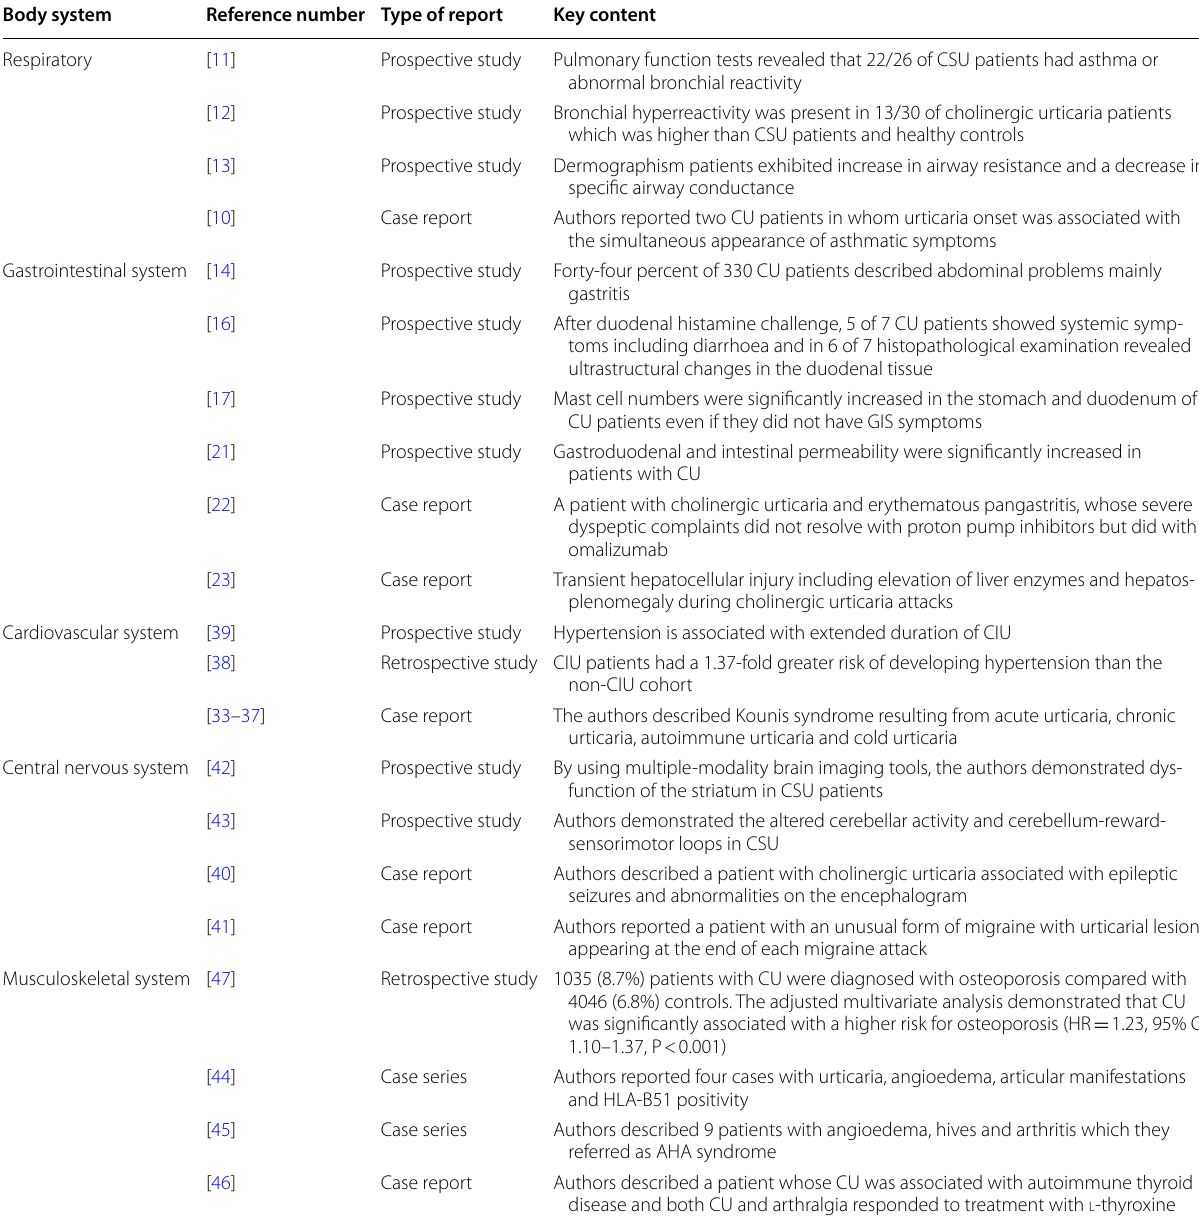
Table 2 Supporting references by body system Body